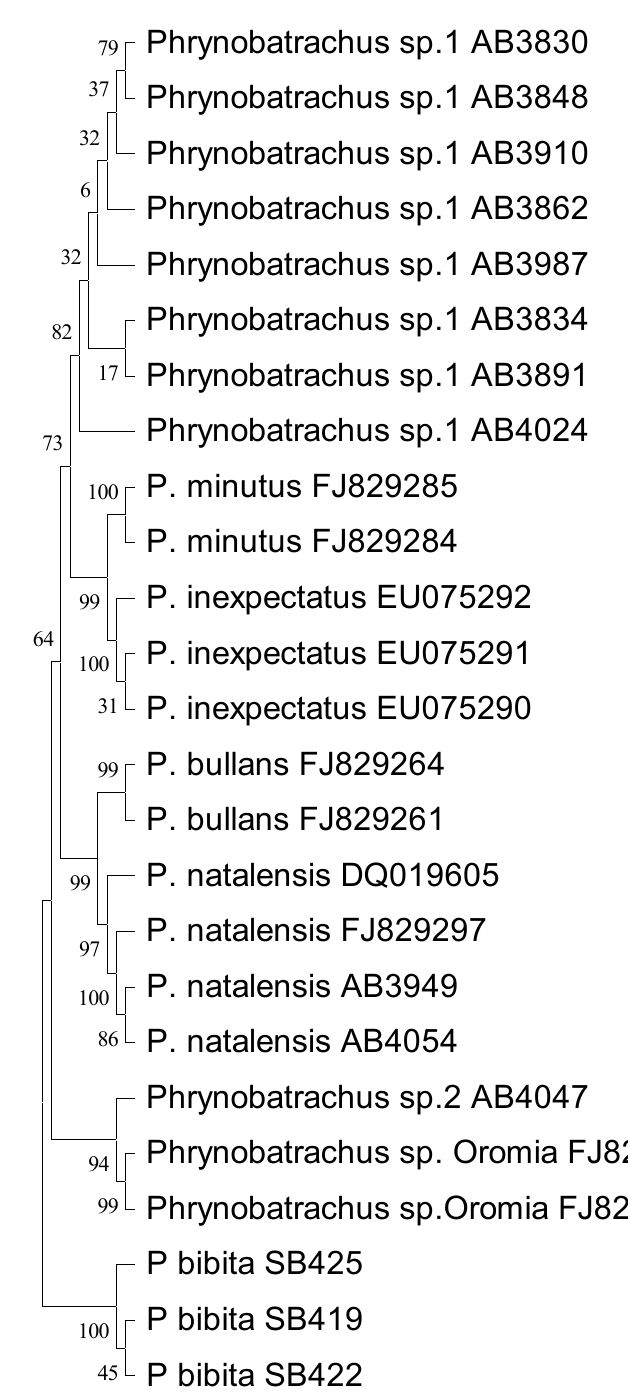
Figure 3. The evolutionary history was inferred by using the Maximum Likelihood method and the Tamura–Nei model [60]. The percentage of trees in which the associated taxa clustered together is shown next to the branches. Initial tree(s) for the heuristic search were obtained automatically by applying Neighbor-Join and BioNJ algorithms to a matrix of pairwise distances estimated using the Tamura–Nei model, and then selecting the topology with superior log likelihood value. This analysis involved 25 nucleotide sequences. Codon positions included were 1st+2nd+3rd+Noncoding.